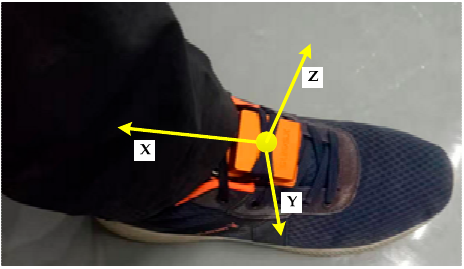
Figure 8. Xsens IMU mounted on the right foot.